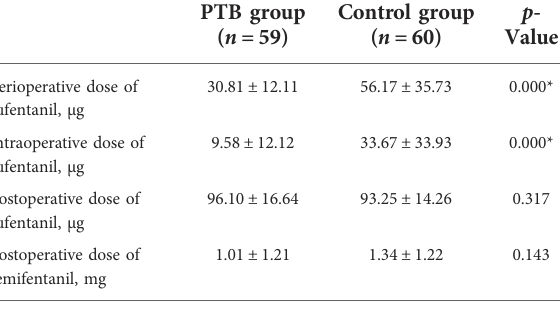
TABLE 2 Perioperative consumption of opioids.